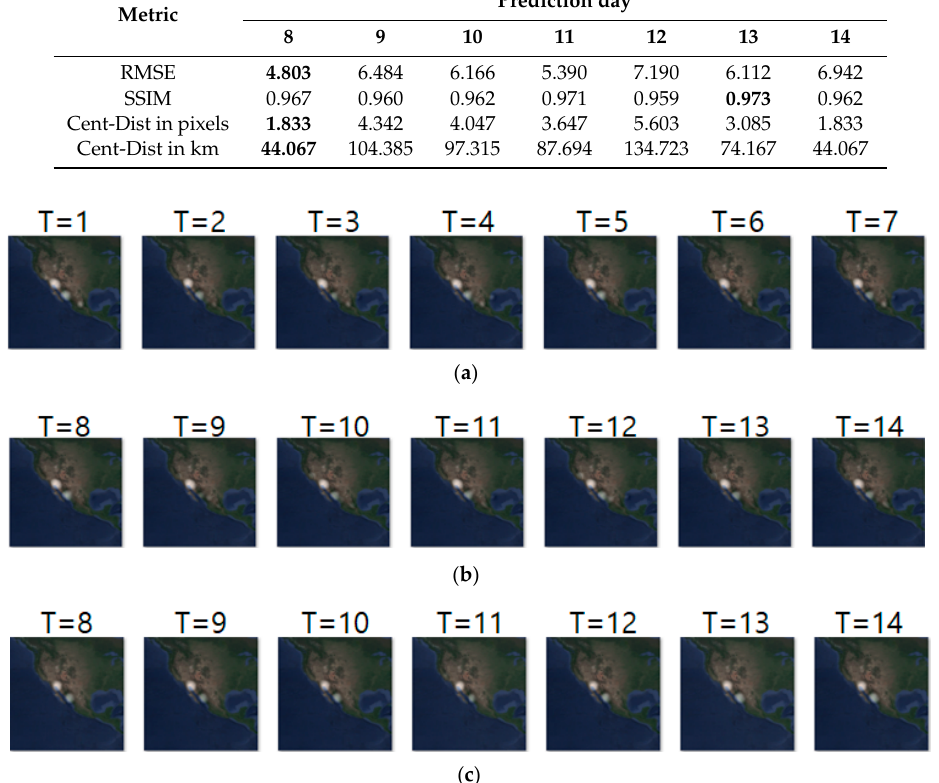
Table 13. Daily comparison of RMSE, SSIM, and centroid distance of case 4.